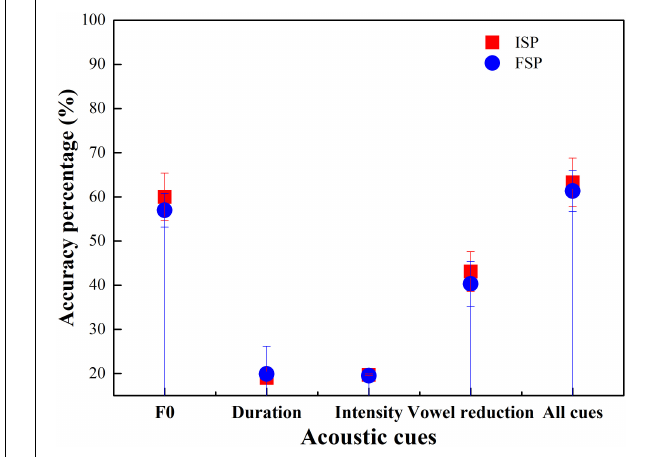
FIGURE 7 | Accuracy for ISP and FSP with the GZ group.